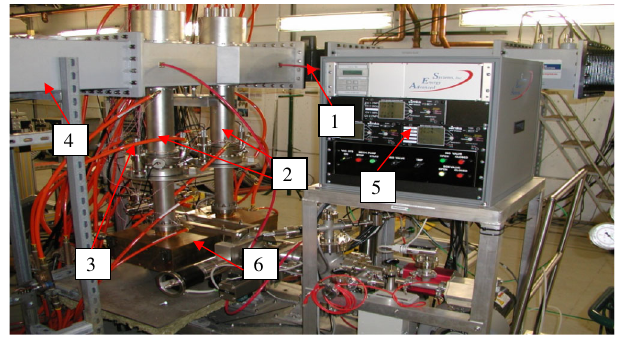
FIG. 15. Assembly of the FPCs for conditioning: 1—waveguide connecting to 1 MW klystron; 2—two FPCs; 3—cooling hoses; 4—waveguide phase shifter and a short plate; 5—vacuum instru- ment on the conditioning cart; 6—connecting waveguide.